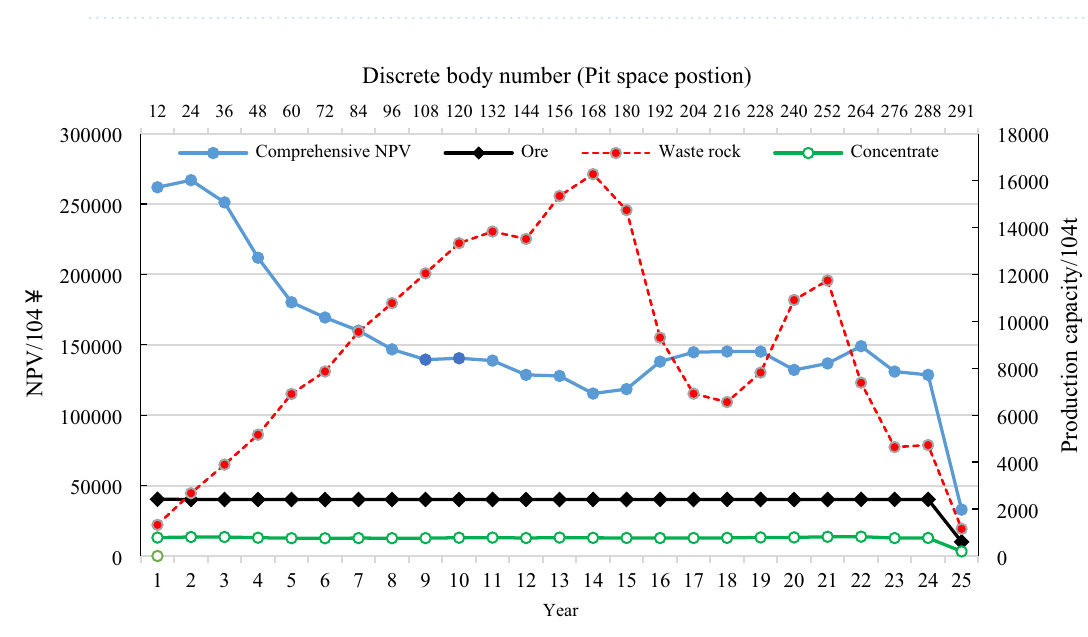
Figure 10. NPV maximum production scheduling with infrastructure